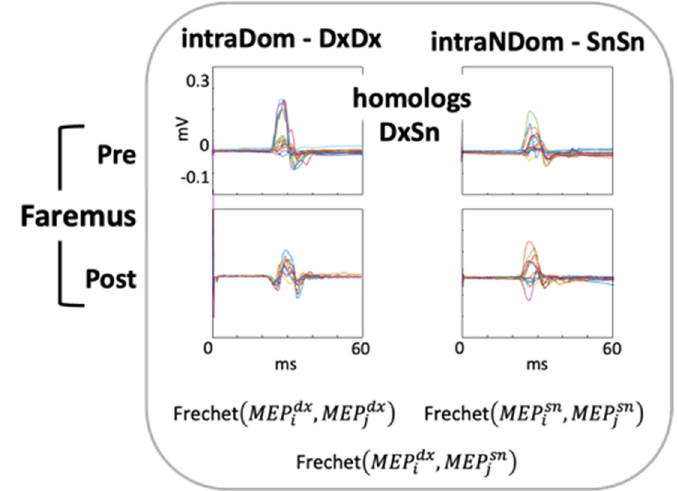
Figure 2. Fréchet distance to assess MEP morphology similarity. Before (Pre) and after (Post) Faremus personalized neuromodulation treatment against MS fatigue; superimposition of about 20 MEPs (colored lines, amplitude scale equal for all conditions) collected in one exemplificative patient. Fréchet distances between left and right MEP morphologies measured the homology of dominant and non-dominant CSTs (homologs, DxSn), and those between the MEP of the same side measured the hemi-lateral pattern recruitment variability (intraDom, DxDx and IntraNDom, SnSn).